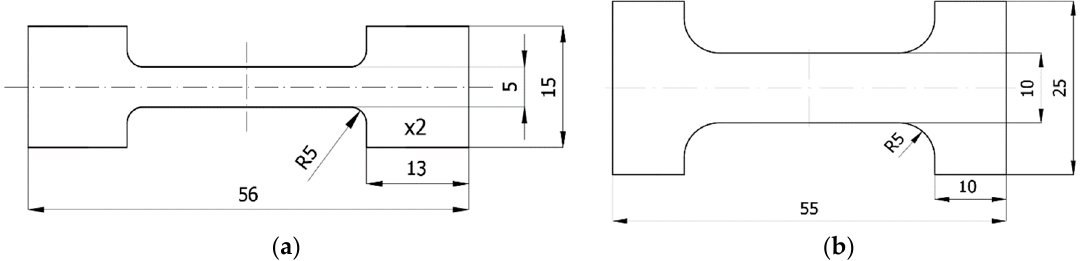
Figure 2. Sample dimensions used for measurements during tension: ( a ) interaction parallel to the direction of the tensile force vector and ( b ) interaction perpendicular to the direction of the tensile force vector.